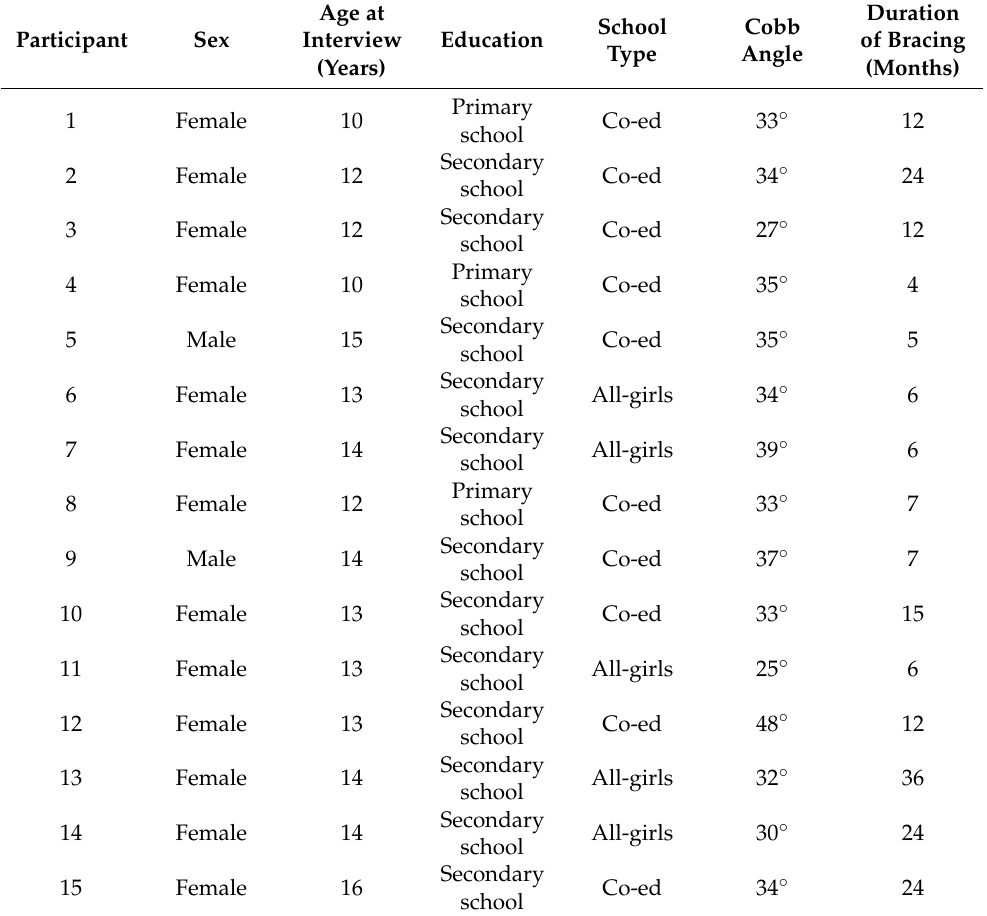
Table 1. Demographic and clinical information of 15 adolescents with scoliosis.